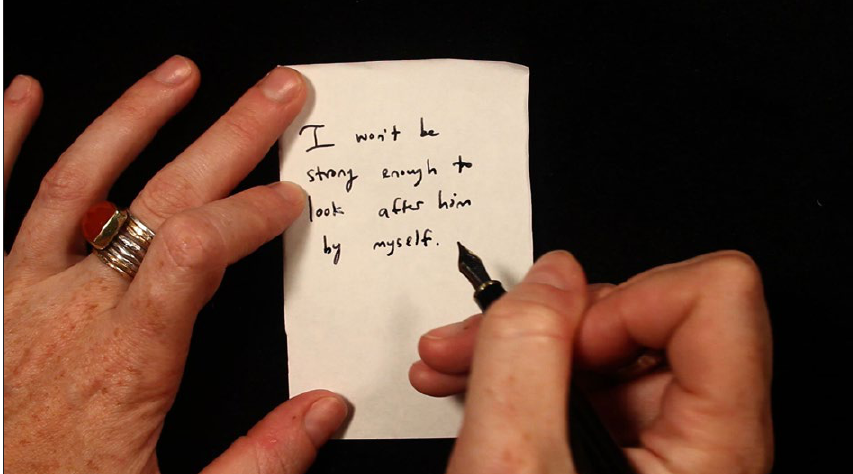
Figure 25: Irene Lusztig, The Worry Box Project , participatory web archive, 2011–